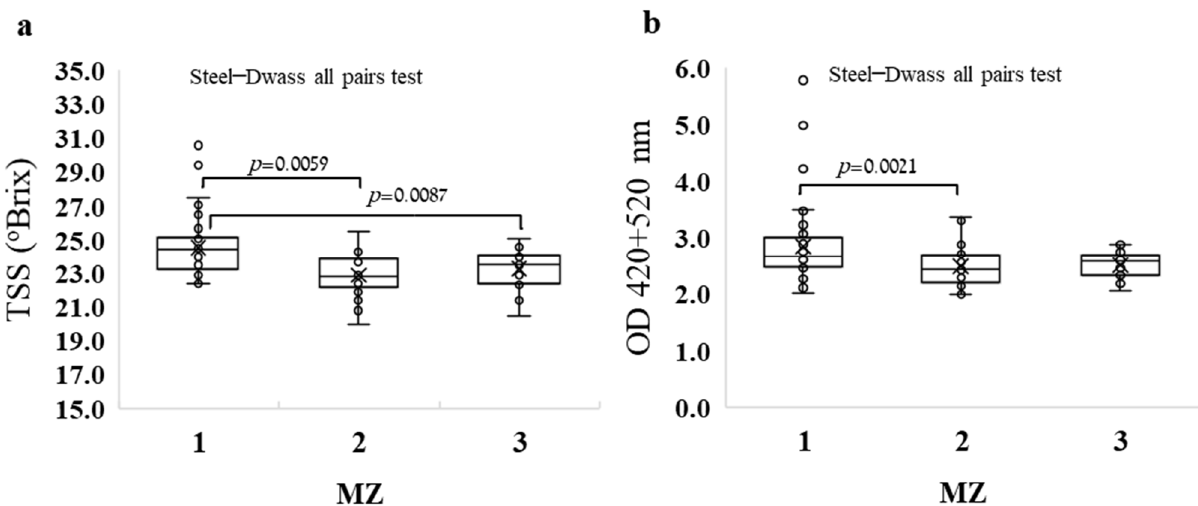
Figure 13. Whisker boxplot of ( a ) TSS and ( b ) fruit must color from the management zones (MZs) in 2018. Significant differences among MZs were calculated according to the Steel–Dwass test, lines with p -values indicate statistically significant difference ( α = 0.05).